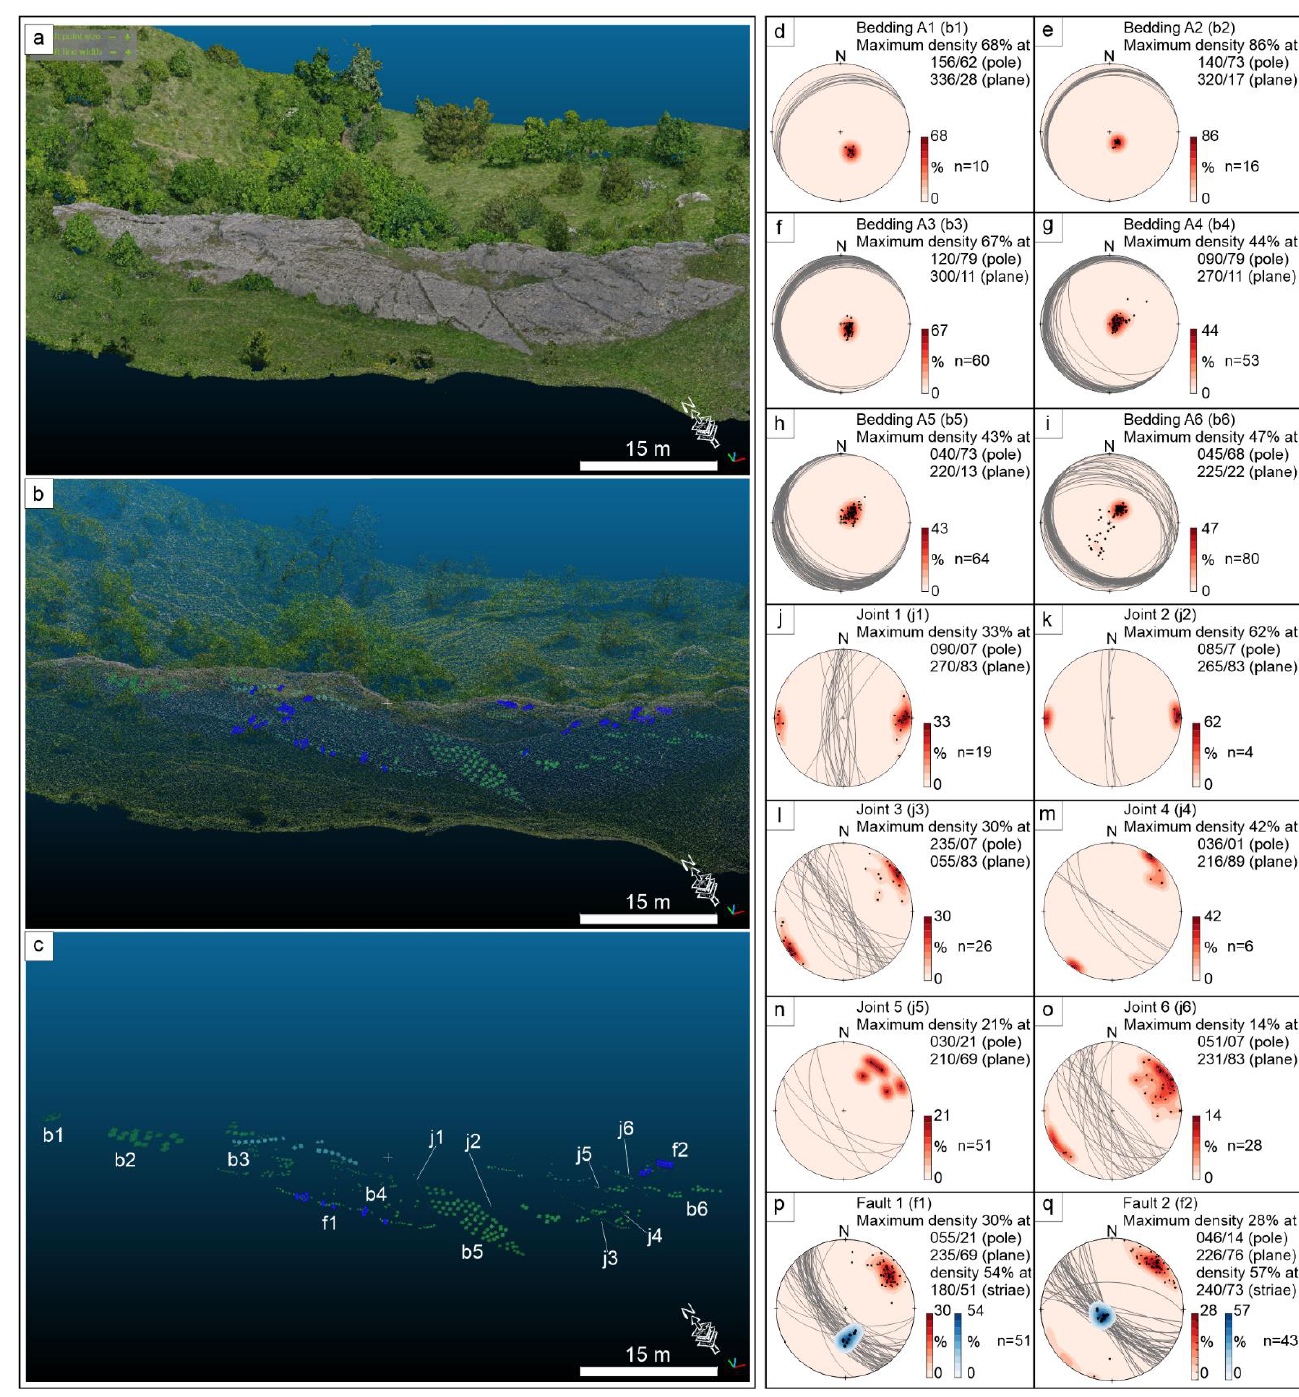
Figure 9. CloudCompare analyses and extraction of the bedding, joint, and fault attitudes. Left panel: ( a ) dense point cloud; ( b ) dense point cloud in transparency and geological features measured; ( c ) geological features measured with the Virtual Compass tool; b, j, f refer to bedding, joint, and fault, respectively. In the right panels the stereographic projection of: ( d – i ) bedding; ( j – o ) joints; ( p , q ) faults, and striations on the fault plane; the subscript number shows the location of the data in panel ( c ).